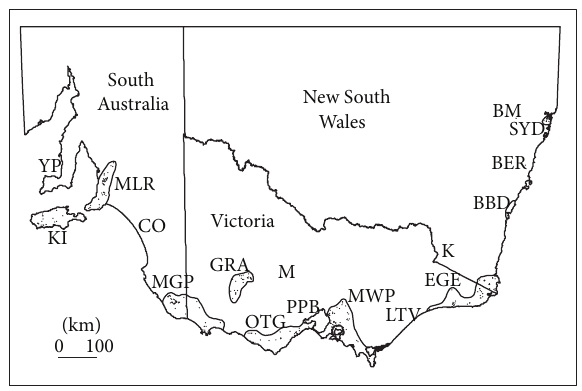
Figure 2: Occurrence records for Isoodon obesulus obesulus in south-eastern Australia. BBD: Batemans Bay to Durras region, BER: Berry, BM: Blue Mountains, CO: Coorong lagoon, EGE: East Gippsland to Eden region, GRA: Grampian Ranges, K: Khancoban, KI: Kangaroo Island, LTV: La Trobe Valley, M: Maldon, MGP: Mount Gambier to Portland region, MLR: Mount Lofty Ranges, MWP: Melbourne to Wilsons Promontory region, OTG: Otway Ranges to Geelong region, PPB: Port Phillip Bay, SYD: Sydney region, YP: Yorke